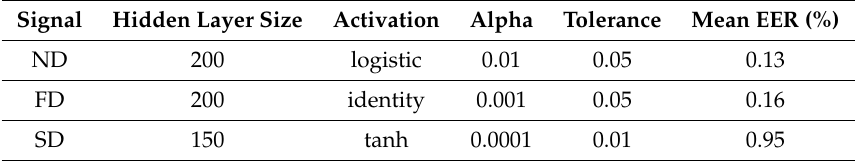
Table 6. Best hyperparameter values in Grid Search and their EERs for ND, FD and SD.